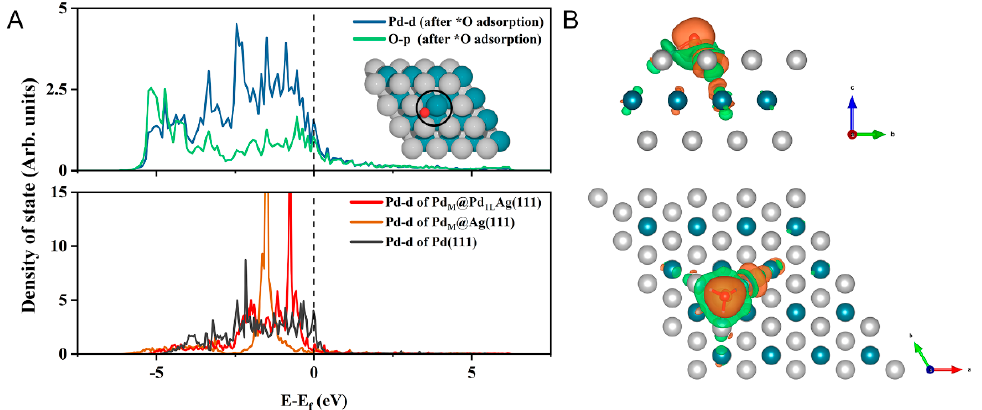
Figure 4. Electronic structure properties of Pd M @Pd 1L Ag(111). ( A ) PDOS plot for the Pd dopant atom as well as the adsorbed O atom (top) and the selected Pd atom in Pd M @Pd 1L Ag(111), Pd M @Ag(111), and Pd(111) (bottom). The position of the Fermi level is marked with the dashed line. ( B ) Isosurface of charge density distribution for adsorbed O atom on the Pd M @Pd 1L Ag(111) system. The charge depletion and accumulation are depicted as cyan and orange colors, respectively. The isosurface value is 0.002 e/Bohr 3 . The silver, cyan, and red balls represent Ag, Pd, and O atoms, respectively. The ORR activity can be evaluated by the thermodynamic limiting potential, 𝑈 (cid:3013) ,